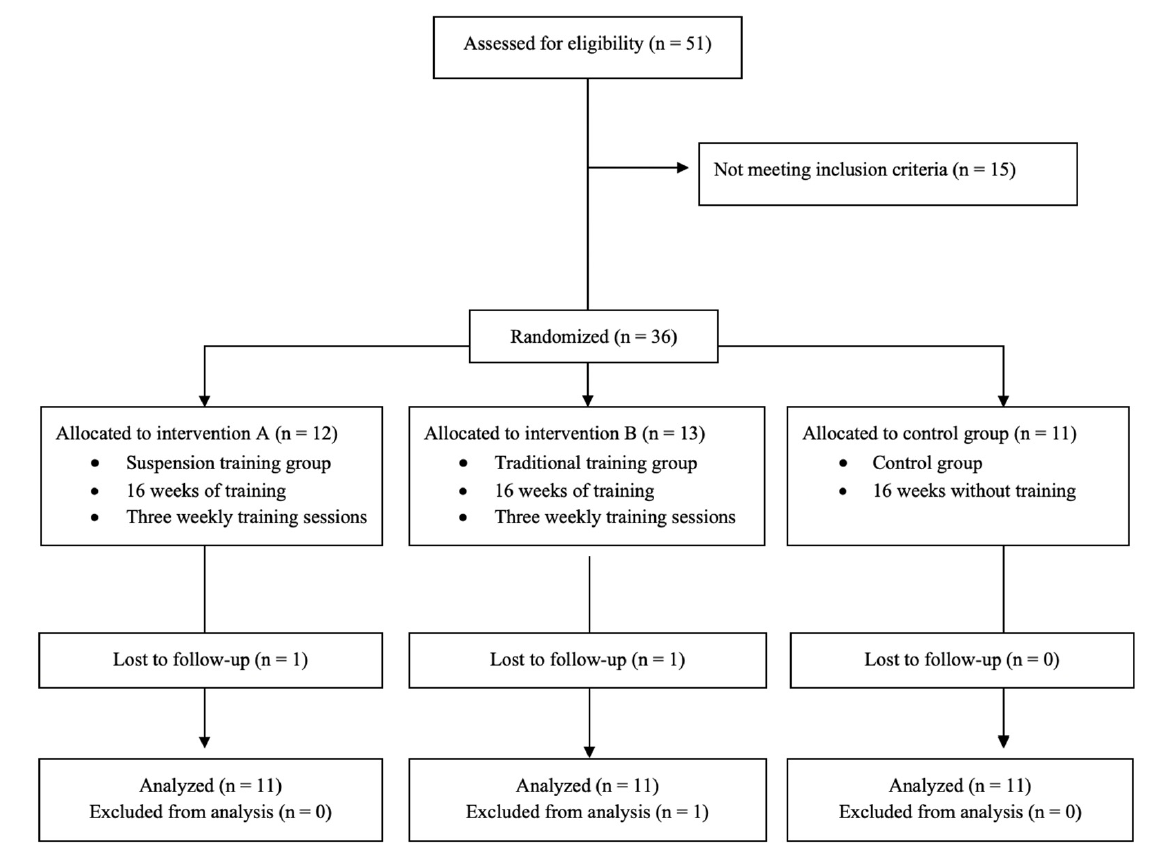
Figure 2. Flow Figure 2. Flow chart.